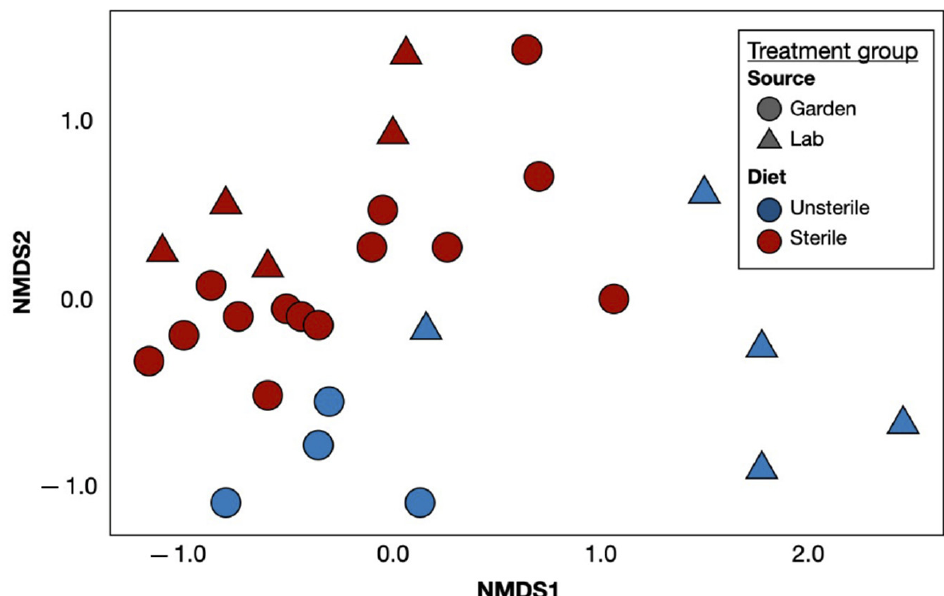
Figure 1. A non-metric multidimensional scaling (NMDS) depiction of unweighted Unifrac distances values illustrates how bacterial communities of Ambigolimax valentianus vary by environmental and dietary treatments. Samples of slugs raised under sterile conditions are represented by red, while slugs in unsterile conditions are symbolized by blue; slugs reared in the lab are represented by triangles and slugs from the garden outside of the laboratory are indicated by circles. Garden Unsterile N = 4, Garden Sterile N =14, Lab Unsterile N = 4, Lab Sterile N = 5.